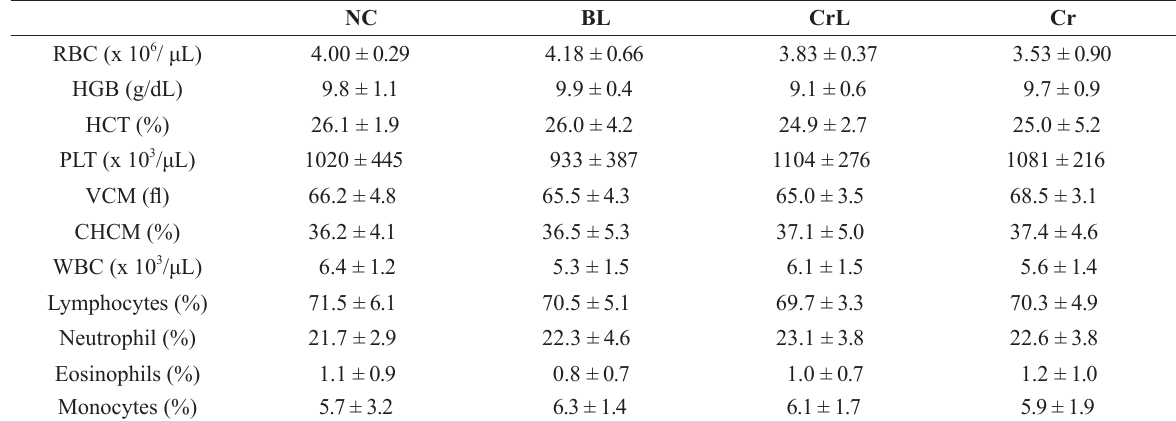
Effect of different treatments with creatine on hematological parameters.